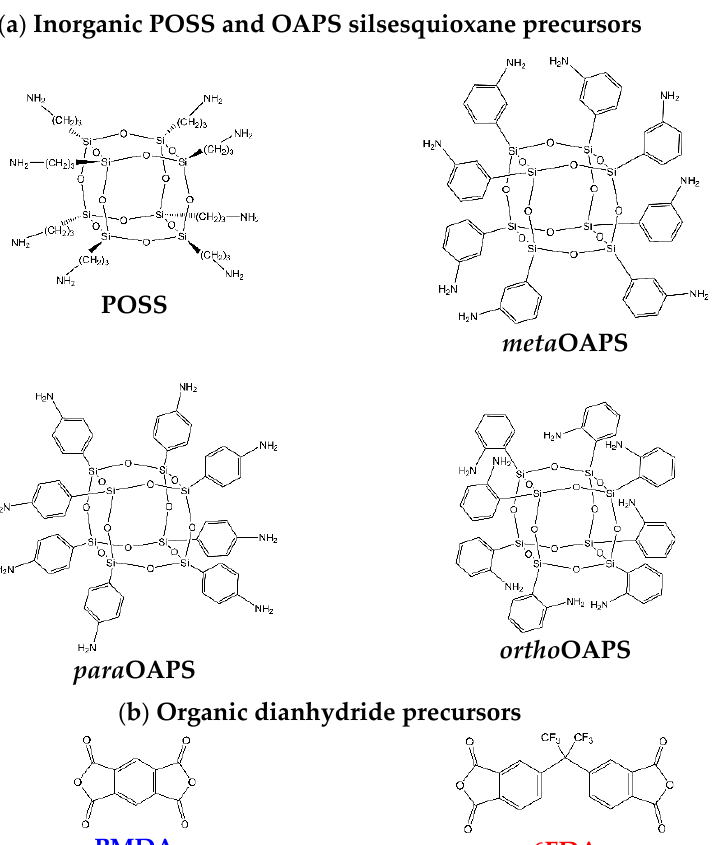
Figure 1. The ( a ) four inorganic and ( b ) two organic precursors used for the polyPOSS-imides and polyOAPS-imides networks under study.